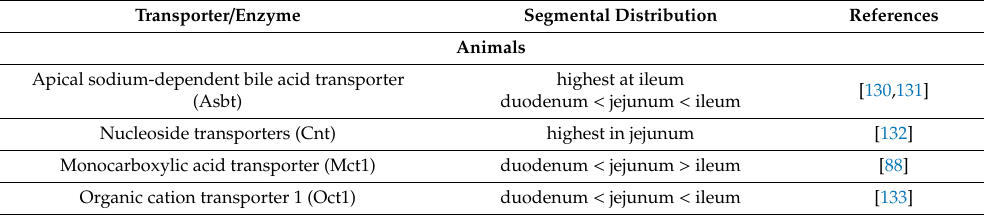
Table 4. Heterogeneous distribution of enzymes and transporters in animal and human